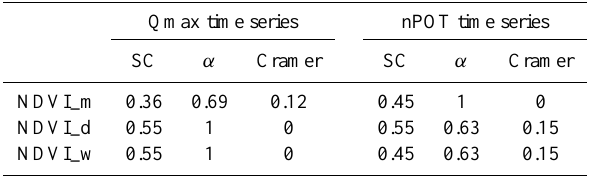
Table 10. SC and Cramer criterion values for the NDVI trends com- pared to Qmax trends and nPOT trends for the set of 11